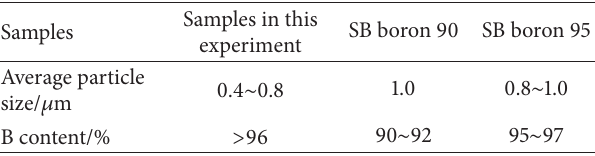
Table2:ComparisonofparticlesizesbetweenamorphousBpowder produced with 50% NaCl and B powder produced by SB boron.